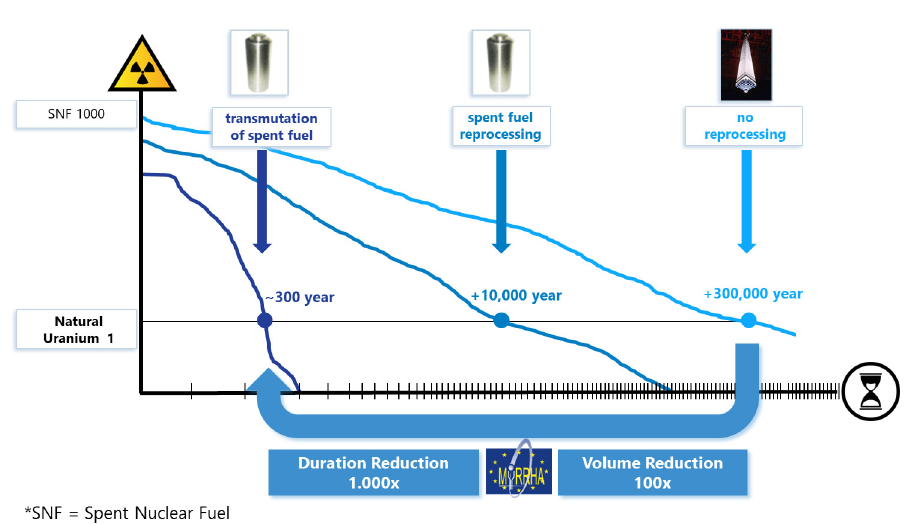
Fig. 4. – Comparison of radiotoxicity of the spent nuclear fuel as a function of time for three situations: a) direct disposal without reprocessing, b) classical PUREX reprocessing and dis- posal of vitrified HLW including FPs and MAs, c) advanced reprocessing extracting MAs and transmuting them and ultimate disposal only